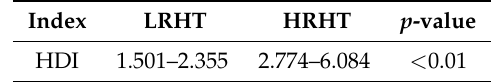
Table 7. Hypertension diagnosis index (HDI) range for the LRHT and HRHT